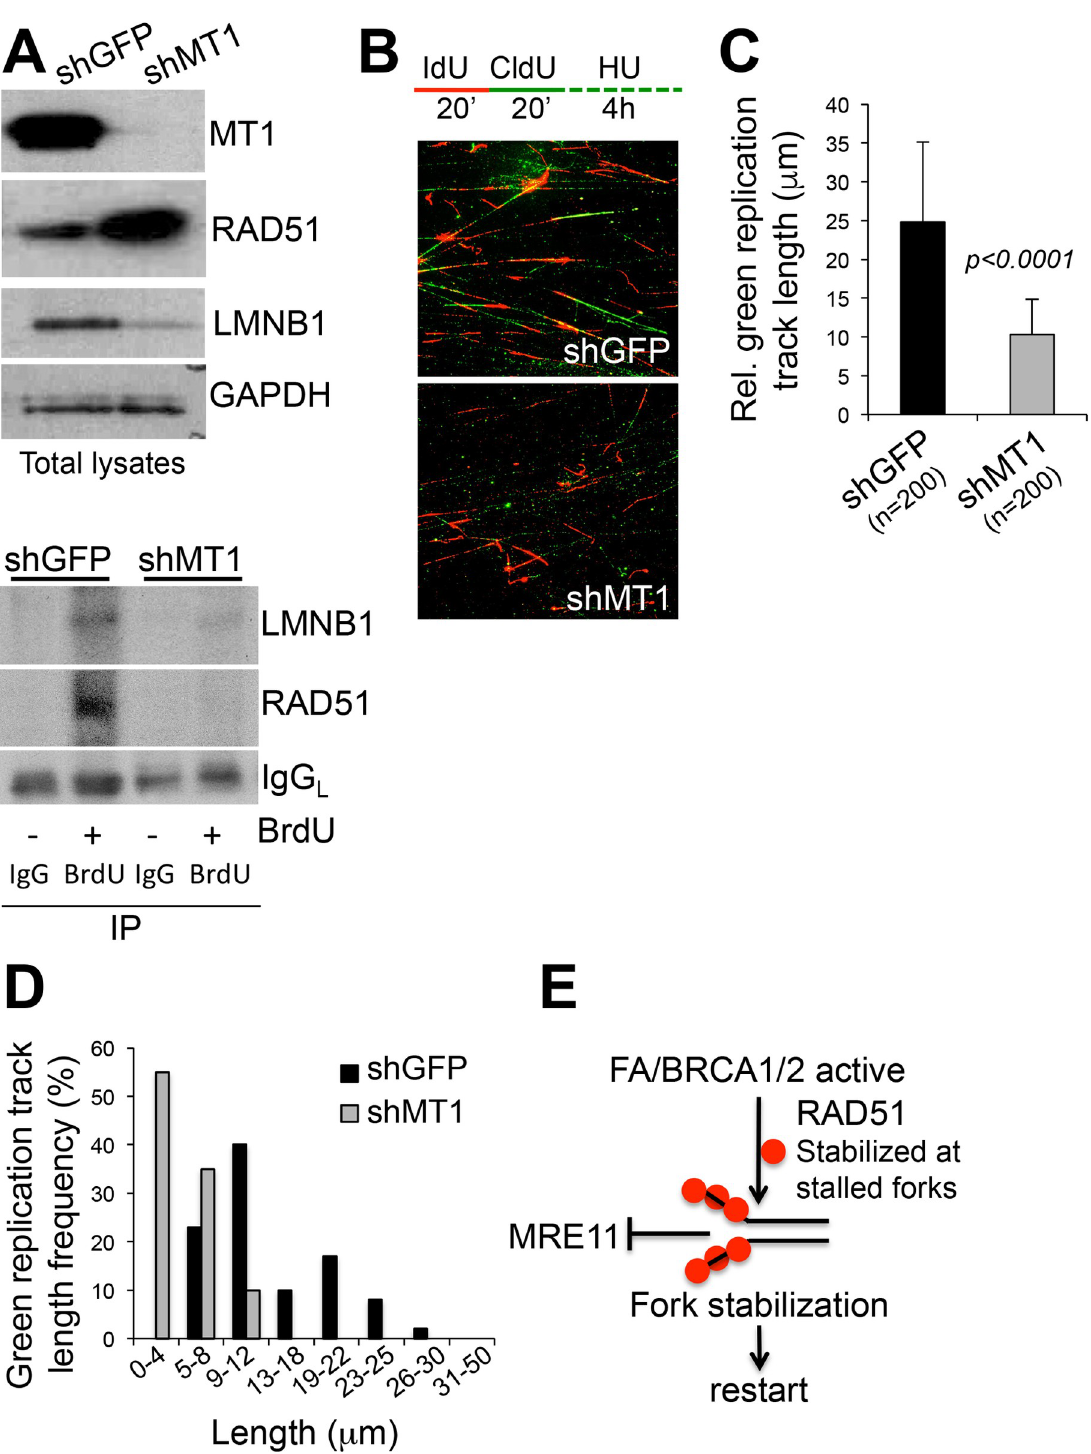
Fig 4. MT1-MMP regulates laminB1 association to RFs and RF degradation. A) Upper panel: Western blotting of total lysates of MDa- MB-231 cells expressing shGFP or shMT1-MMP. Levels of LaminB1 (LMNB1) and of the RF protection factor RAD51 are shown. GAPDH was used as loading control. Bottom panel: Cells in A were labeled with BrdU (+) or left unlabeled (-), then BrdU immunoprecipitation was performed. An IgG antibody was used to immunoprecipitate unlabeled samples. IgG light chain (IgG L ) was used as loading control. Western blotting shows levels of laminB1 and RAD51 bound to replication forks. B) Cells expressing shGFP or